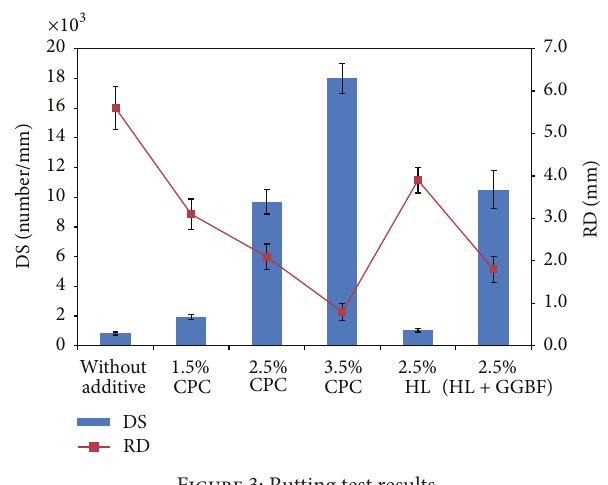
Figure 3: Rutting test